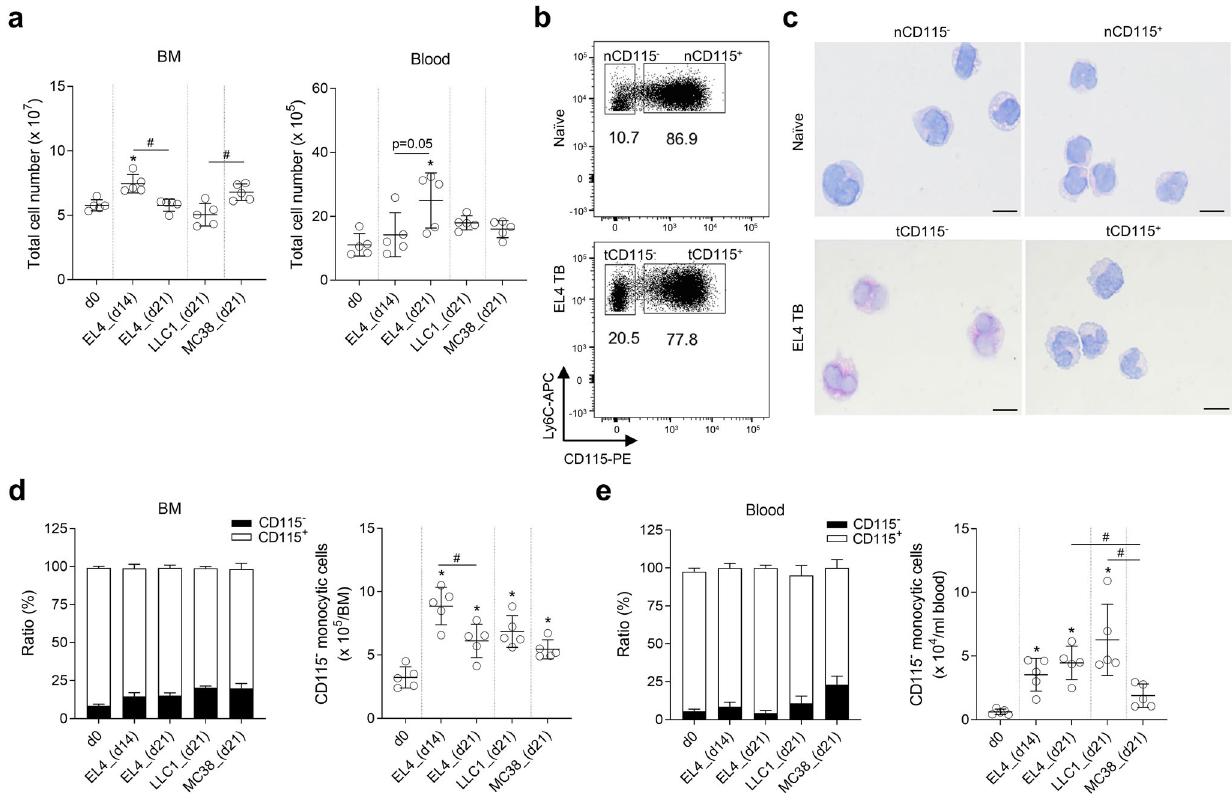
Fig. 1 TB mice have increased levels of CD115 − M-MDSCs in BM. a Total BM and blood cell counts in naive and EL4, LLC1, and MC38 TB mice at indicated days after tumor implantation ( n = 5 per group). b Representative plot shows CD115 − and CD115 + monocytic cells (CD11c − CD11b + Ly6G − SiglecF − Ly6C hi ) in naive and EL4 TB mice. The letter “ n ” and “ t ” in front of CD115 indicate that cells were isolated from tumor-free and TB mice, respectively. c Representative images of H&E stained CD115 − and CD115 + cells from BM of naive or EL4 TB mice. Scale bars = 10 μ m. d , e Relative ratios of CD115 − and CD115 + M-MDSCs and absolute numbers of CD115 − monocytic cells in BM ( d ) and blood ( e ) of EL4, LLC1, and MC38 TB mice ( n = 4 or 5 in each group). One-way ANOVA with correction for multiple comparisons test was used: * p < 0.05 (all vs. d0); # p < 0.05. Data are mean ±